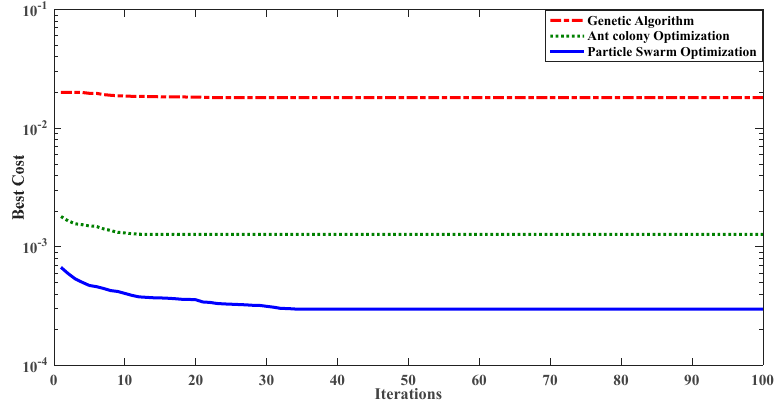
Figure 11. Convergence characteristics of GA, ACO, and PSO.